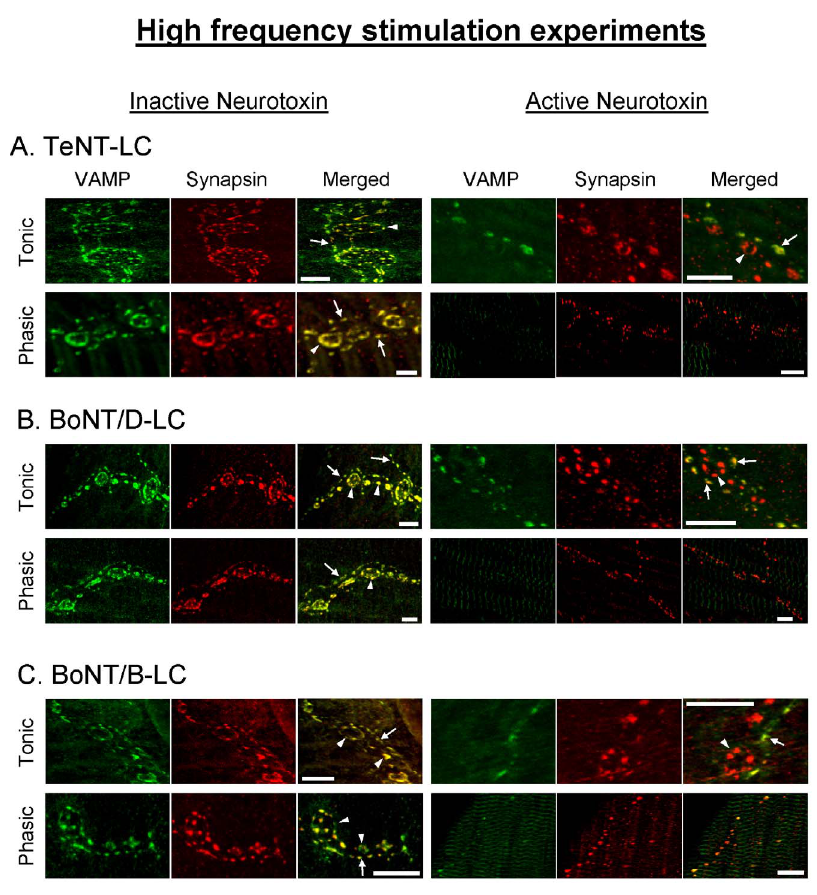
Figure 8. VAMP in phasic and tonic axonal terminals is susceptible to Clostridial neurotoxins under high frequency stimulation. Immunostaining of VAMP and synapsin following the high frequency stimulation experiments using inactive and active TeNT-LC ( A ), BoNT/D-LC ( B ) and BoNT/B-LC ( C ). In A-C , arrows denote phasic terminals and arrow heads denote tonic terminals. Areas of overlap between VAMP and synapsin immunoreactivity are denoted in yellow in the merged image. Note that all three active neurotoxins reduced VAMP immunoreactivity. In A - C , no